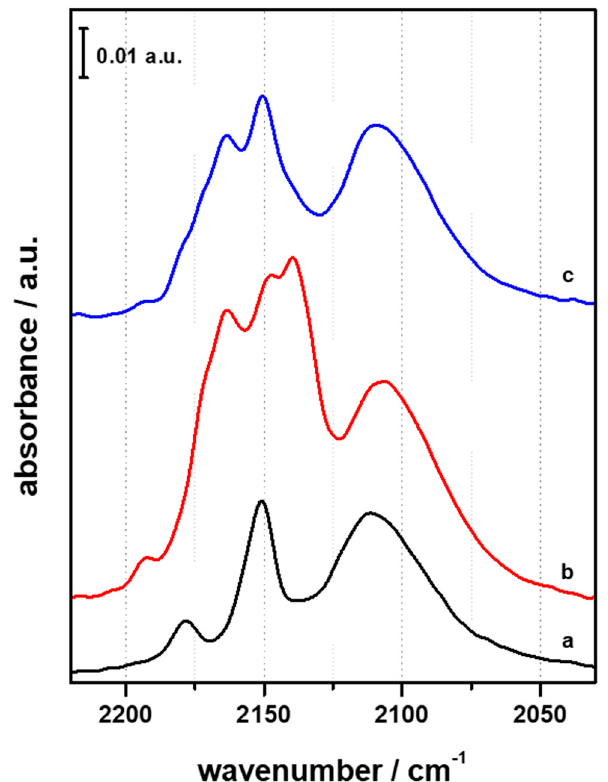
Figure 5. FTIR difference spectra of CO adsorbed at r.t. (a, black curve), at LN temperature (b, red curve) and at LN temperature after outgassing until the disappearance of the CO liquid-like signal at 2138 cm − 1 (c, blue curve).